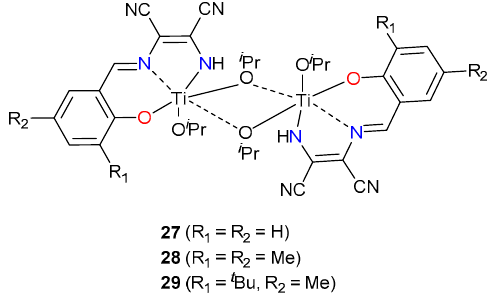
Figure 5. Cyano-containing Ti-complexes 27–29 [45] .